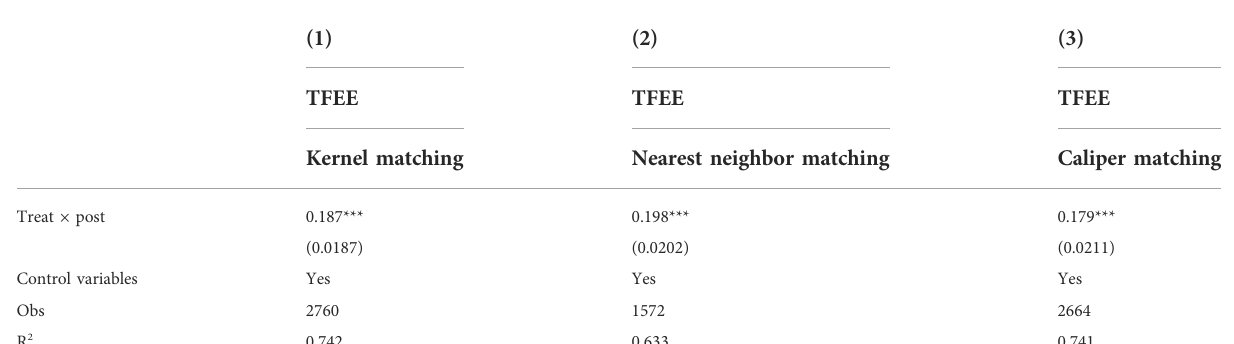
TABLE 5 PSM – DID estimation.